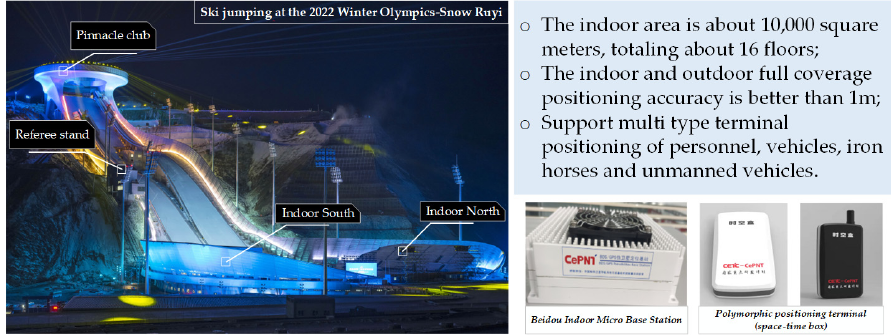
Figure 21. Application of indoor positioning system for 2022 Winter Olympics.